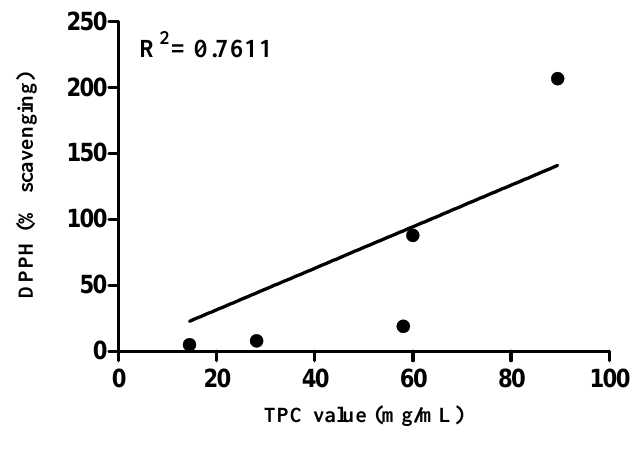
Figure 1. Correlation between TPC and DPPH scavenging percentage.